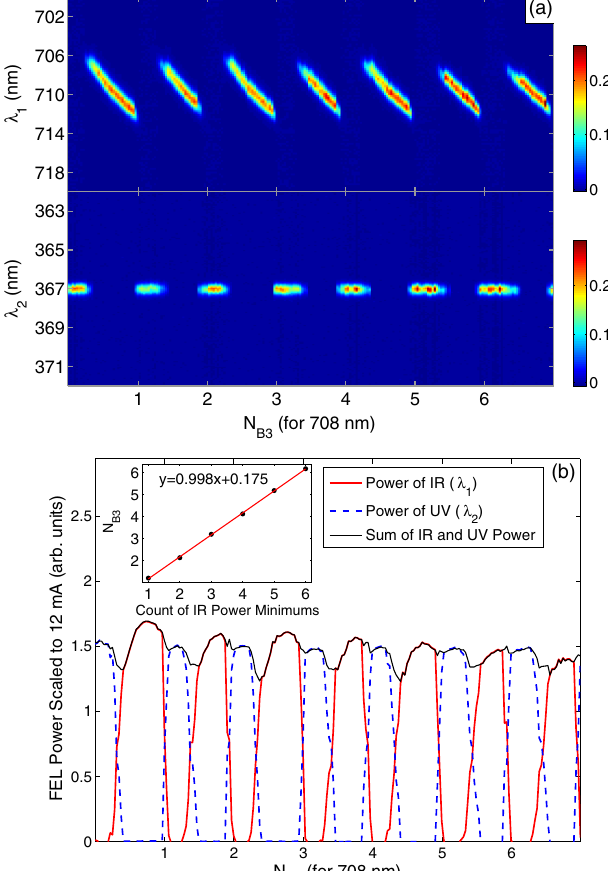
FIG. 7. Two-color FEL power control by tuning buncher B3 with the four-undulator configuration and loss curves L2. The beam current is kept between 12.01 mA and 12.79 mA. (a) The measured spectra. (b) The FEL power of IR lasing (red solid), UV lasing (blue dashed), and the sum of the two powers